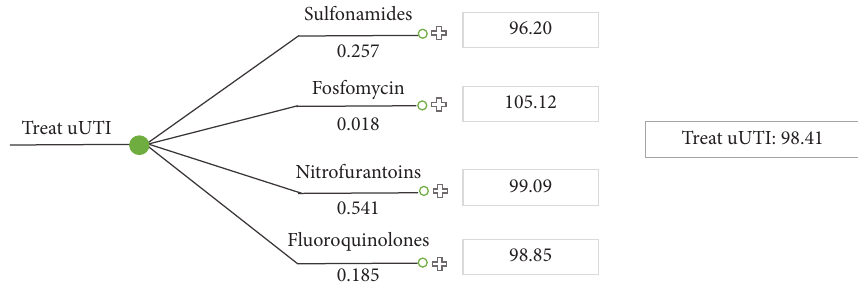
Figure 4: Weighted average cost-per-patient for treating uUTI in Ontario with fosfomycin.